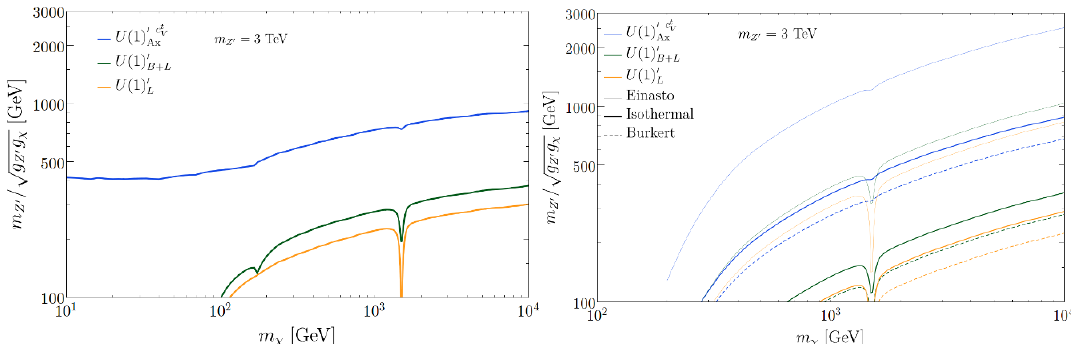
Figure 5 . Limits from continuum (cid:13) ray emission on the three models we consider. Left: bounds from Fermi-LAT observations of dSphs [6, 7]. Right: bounds from HESS observation of the Galactic Center [8], for three choices of the DM pro(cid:12)le